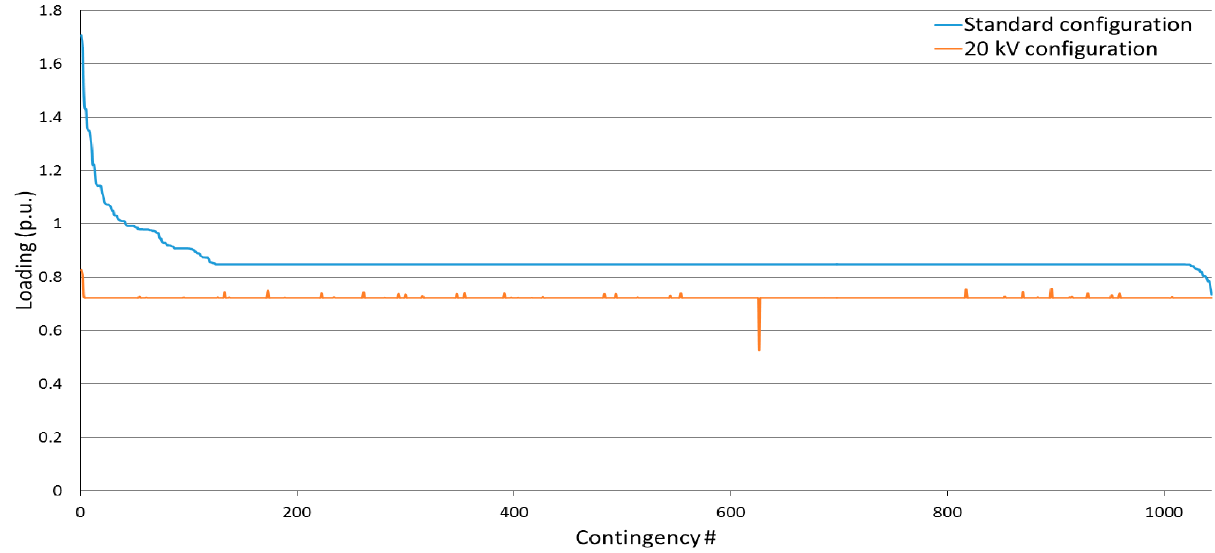
Figure 11. Comparison between maximum branch loadings (in per unit of the branch capacity) for the PDN standard configuration (blue line) and the 20 kV configuration (orange line).